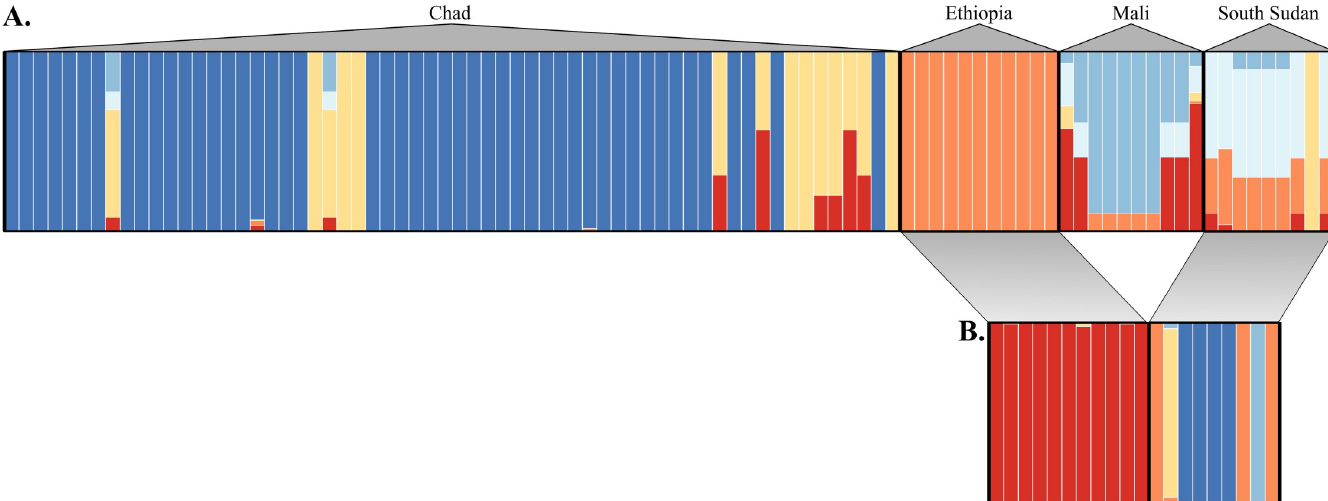
Fig 5. Inference of D . medinensis population subdivision among the four endemic countries. (A) Posterior assignment of individual D . medinensis worms collected from the four endemic countries into K = 6 clusters of shared ancestry. (B) Assignment of worms from only Ethiopia and South Sudan into K = 4 clusters of shared ancestry. In both analyses, each bar represents an individual worm and color indicates proportional assignment to one or more clusters. Bar colors are only informative within each assignment analysis, not between the two. Most likely K was inferred using the TI method in MavericK v1.0